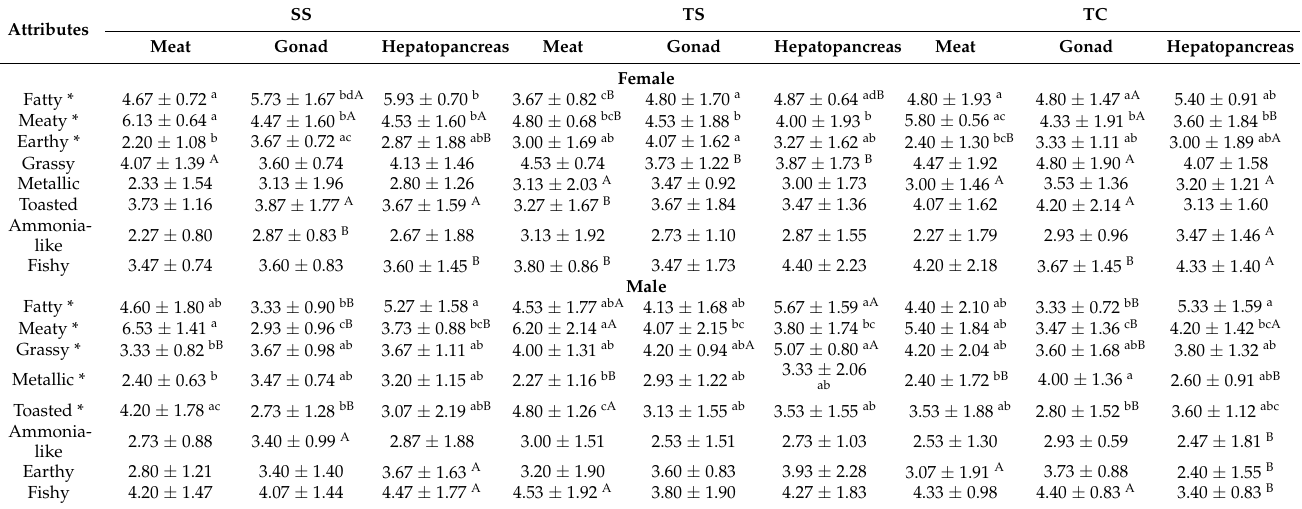
Table 3. Comparison of attributes used to describe three edible parts (meat, gonads, and hepatopan- creas) of E. sinensis